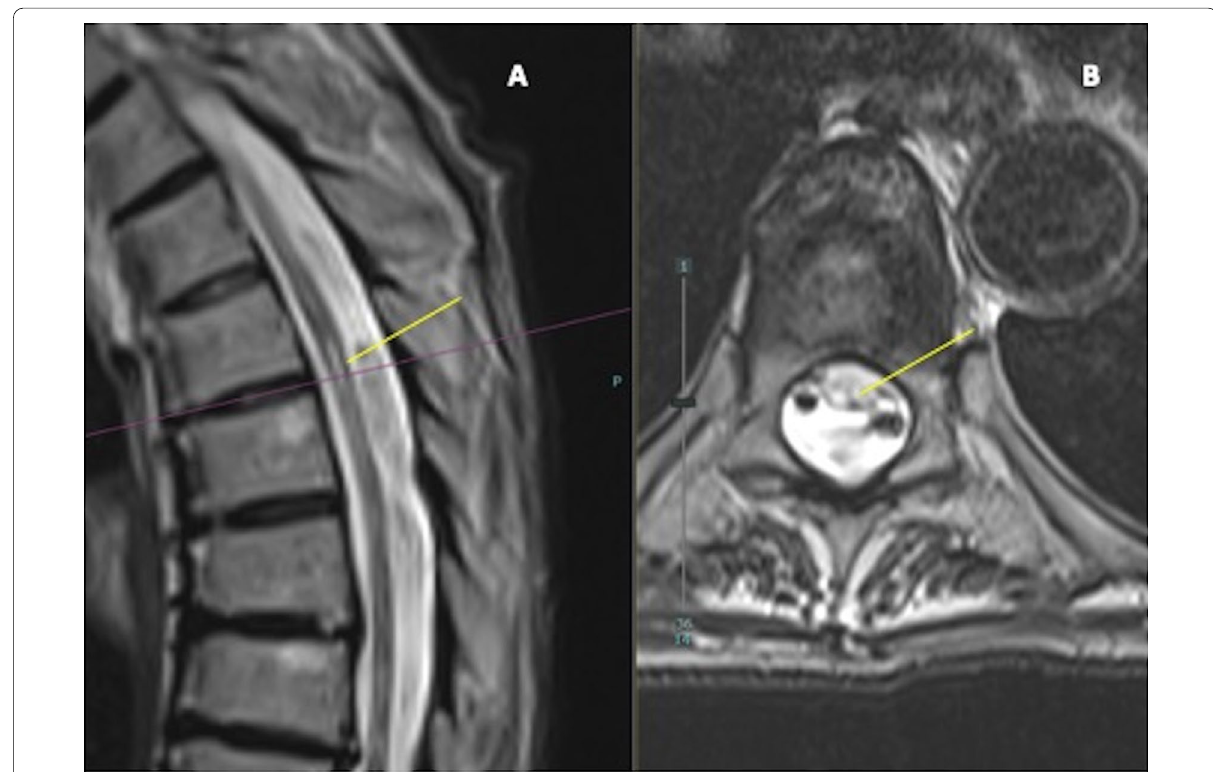
Fig. 1 MRI sagittal T2 image ( A ) of the thoracic spine demonstrates an intramedullary mid-thoracic cord lesion (yellow arrow), with a corresponding focus that is as bright or brighter than CSF on the axial images ( B ) (yellow